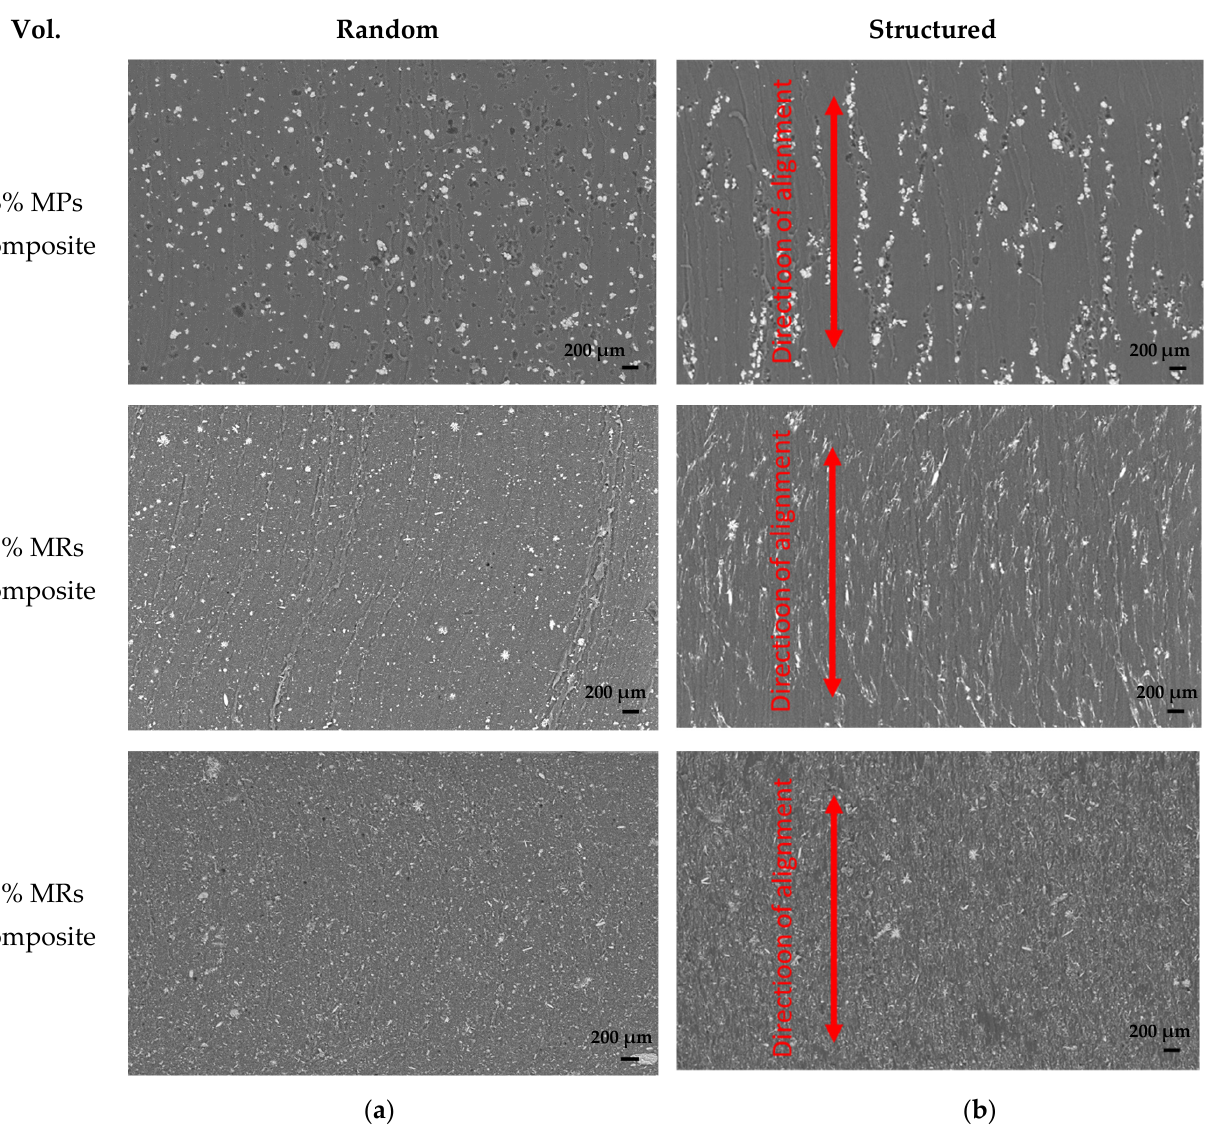
Figure 8. SEM images of ( a ) Random and ( b ) Structured composites integrating 8% vol. MPs, 2% vol. MRs and 8% vol. MRs under an applied electric field ( E app = 0.6 V/ µ m, f app = 2 Hz) during the DEP process (the scale bar is 200 µm).